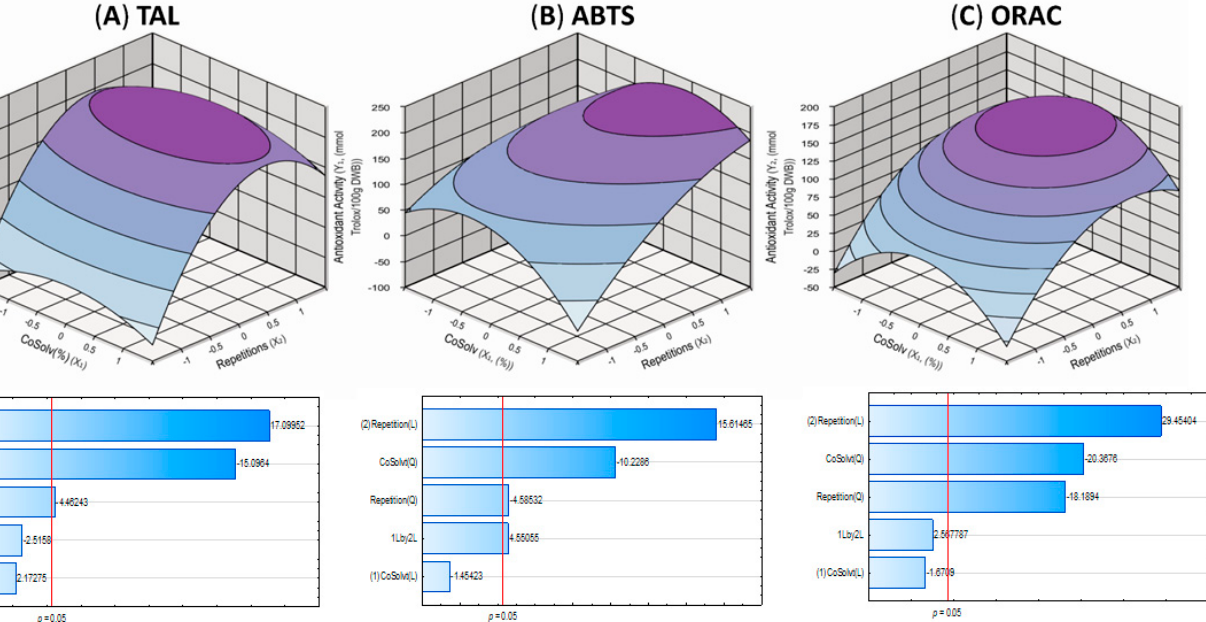
Figure 2. ( A ) Surface model for total anthocyanin level (TAL) (mg/100 g dry matter) from Ch-Xyl extract from E. edulis pulp for repetition and co-solvent as main effects and Pareto chart of the results. ( B ) Surface model for ABTS (mmol Trolox 100 g − 1 dry matter) and Pareto chart of the results. ( C ) Surface model for ORAC assay (mg/100 g dry matter) and Pareto chart of the results.